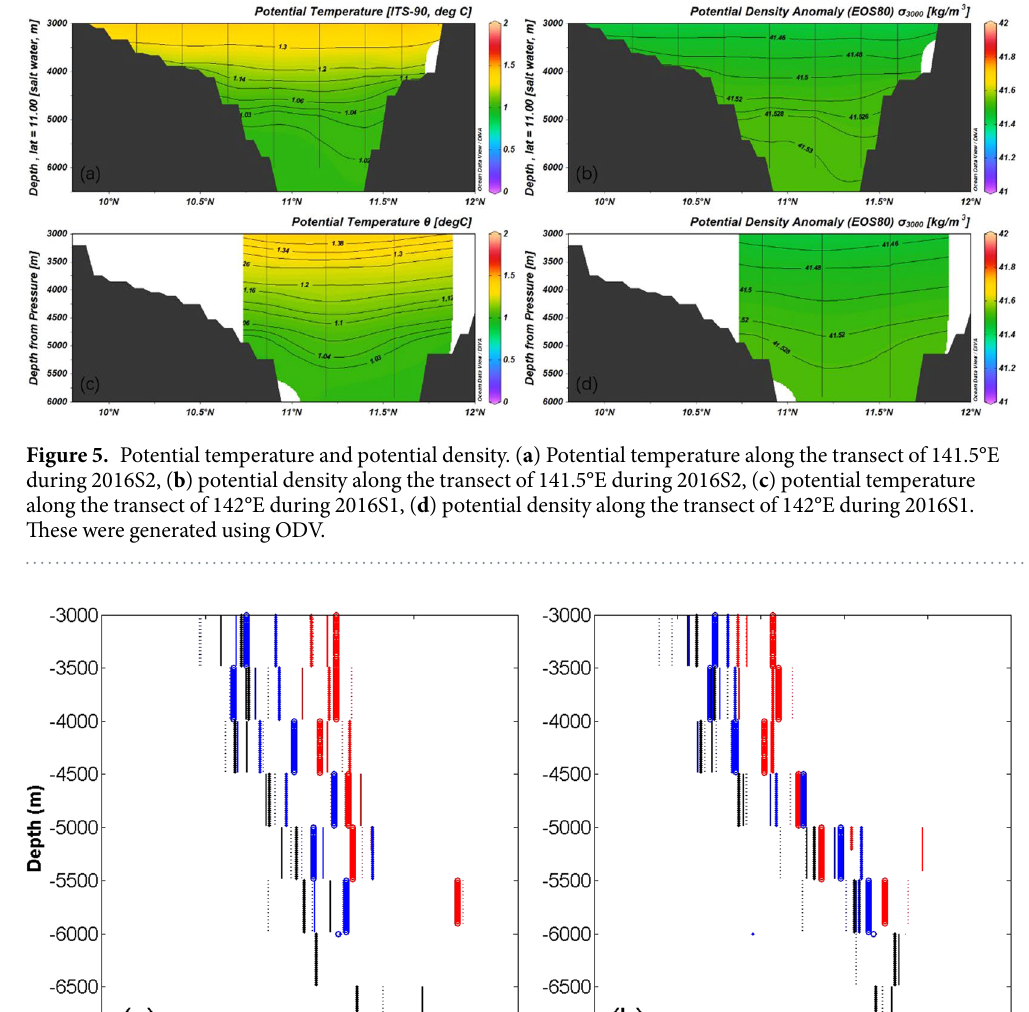
Junction 8 . Water that is denser than 41.52 kg/m 3 does not reach the Philippine Sea, as the ridge prevents cold and dense water from entering. The transect along 141.5°E is closer to the ridge than that along 142°E. Therefore, more cold and dense water is accumulated in the southern area of the transect along 141.5°E.